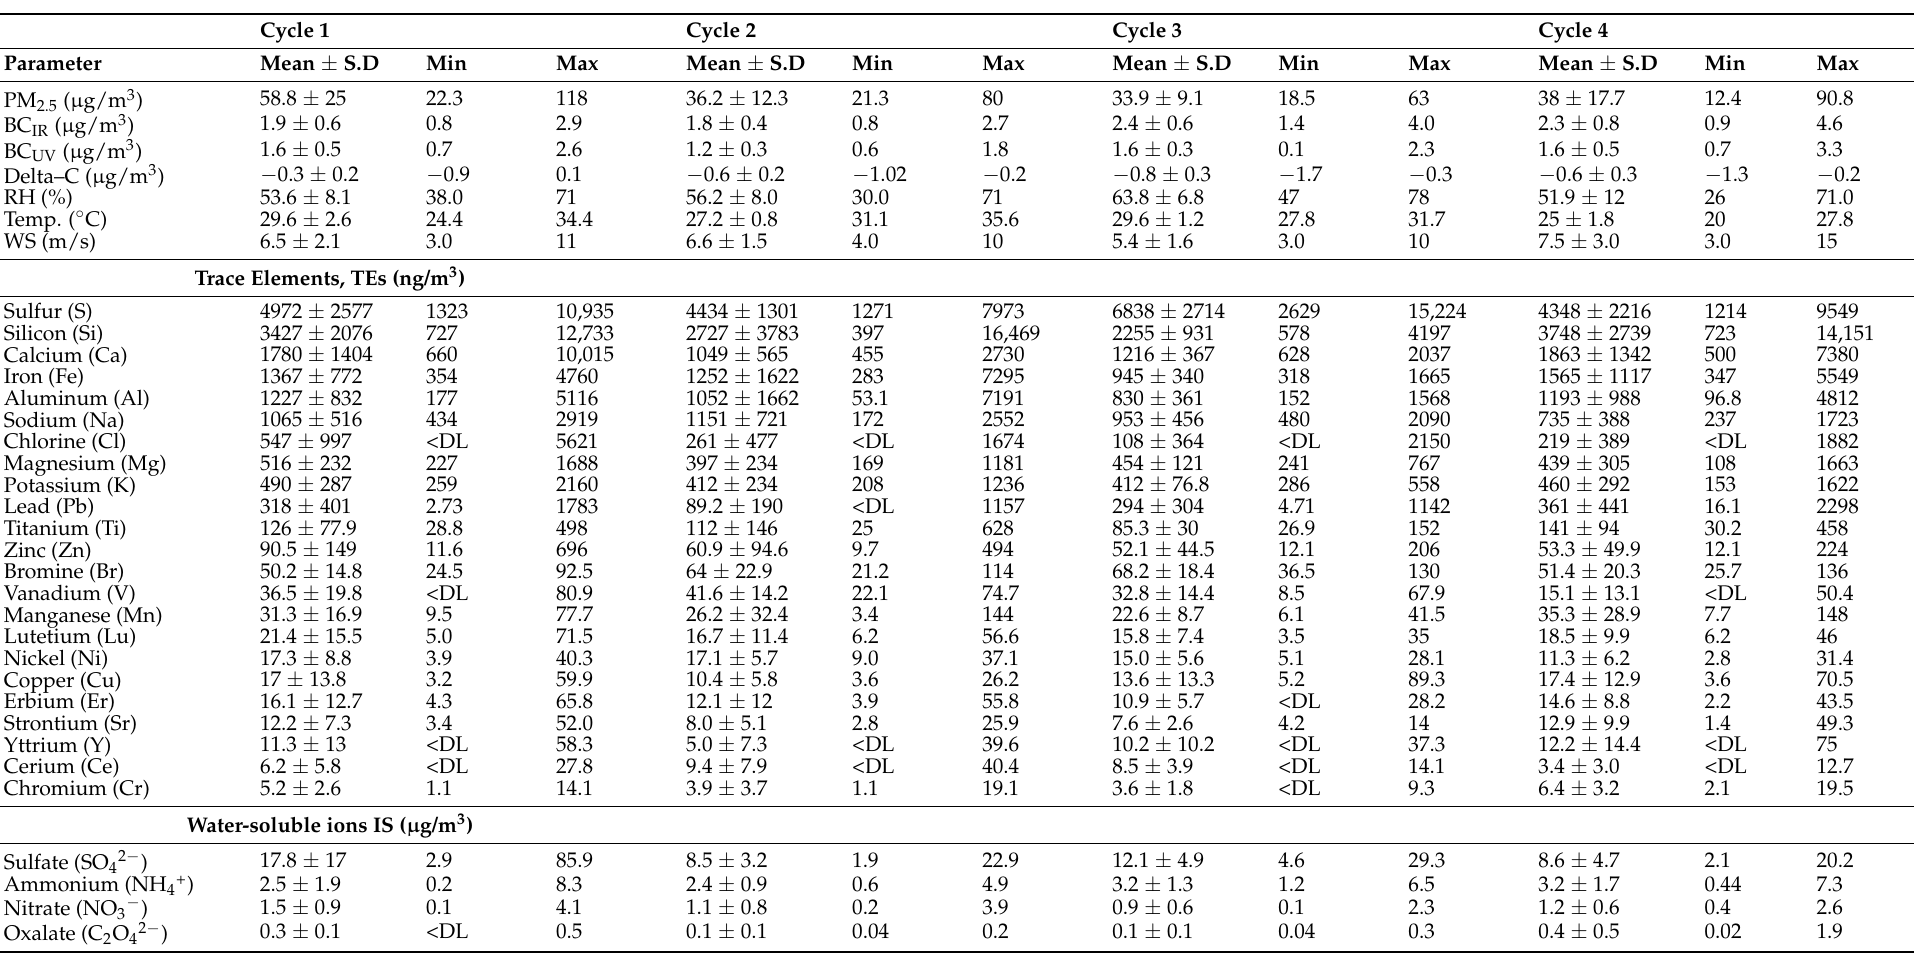
Table 1. Summarized 24-h PM 2.5 , BC, TEs, IS, and meteorology (mean daily temperature, relative humidity (RH) and wind speed (WS)) per sampling cycle in